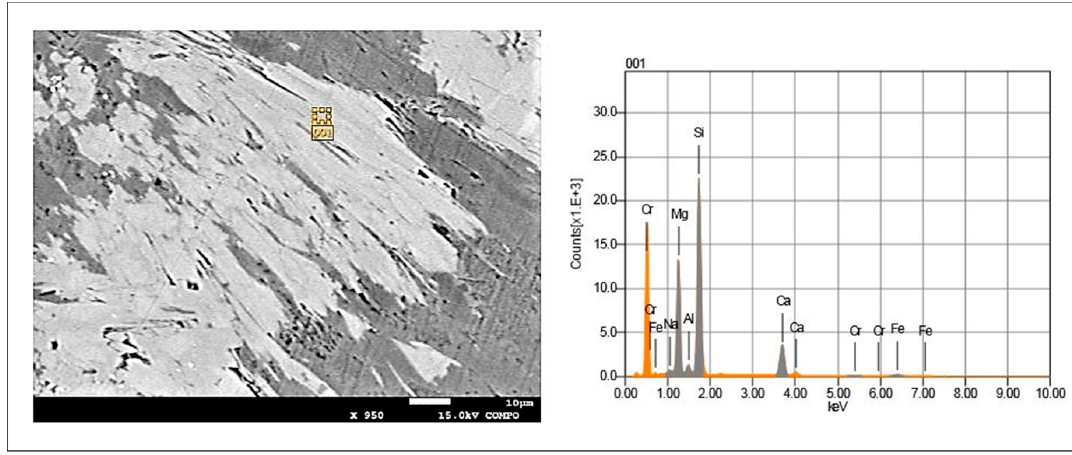
Figure 5. Secondary-electron image (SEI) of the fibrous tremolite and relative spectrum of the fibres.